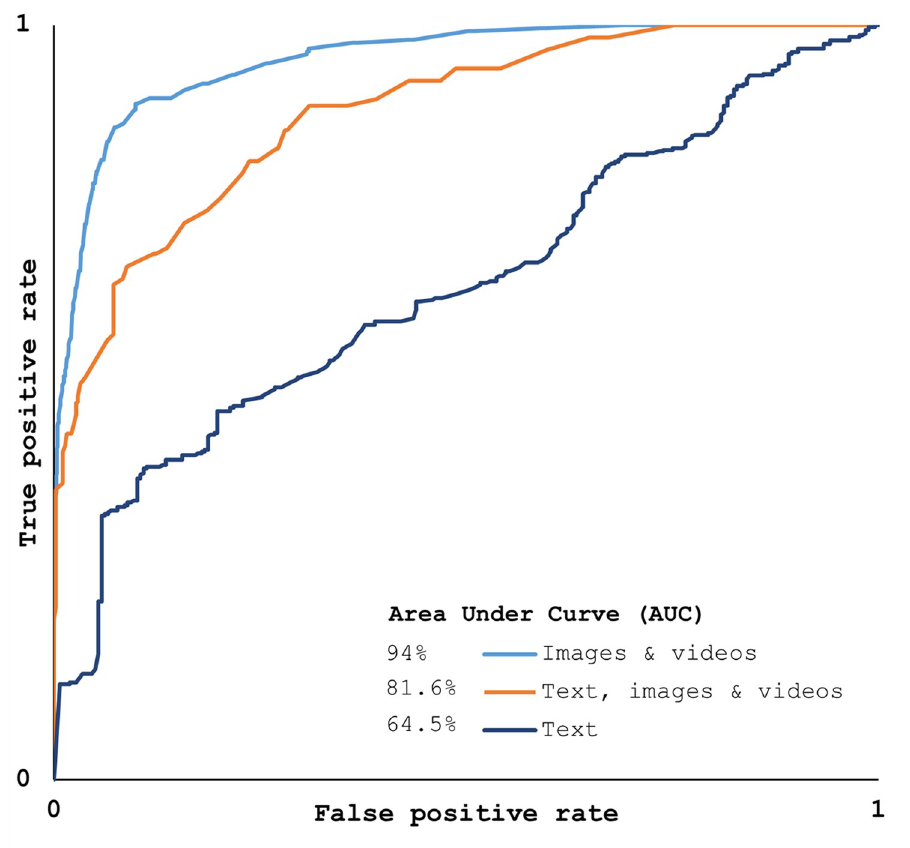
Fig 7. Area under Curve (AUC) for three set of data formats using random